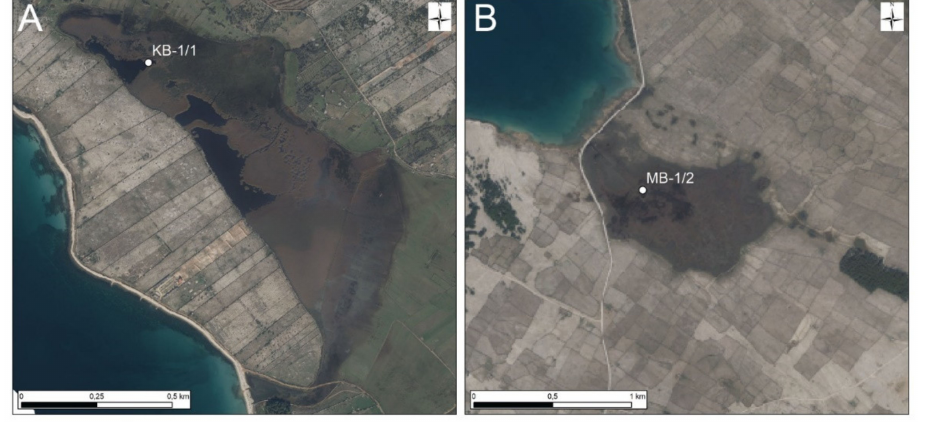
Figure 5. Sampling locations in Kolanjsko ( A ) and Malo Blato ( B